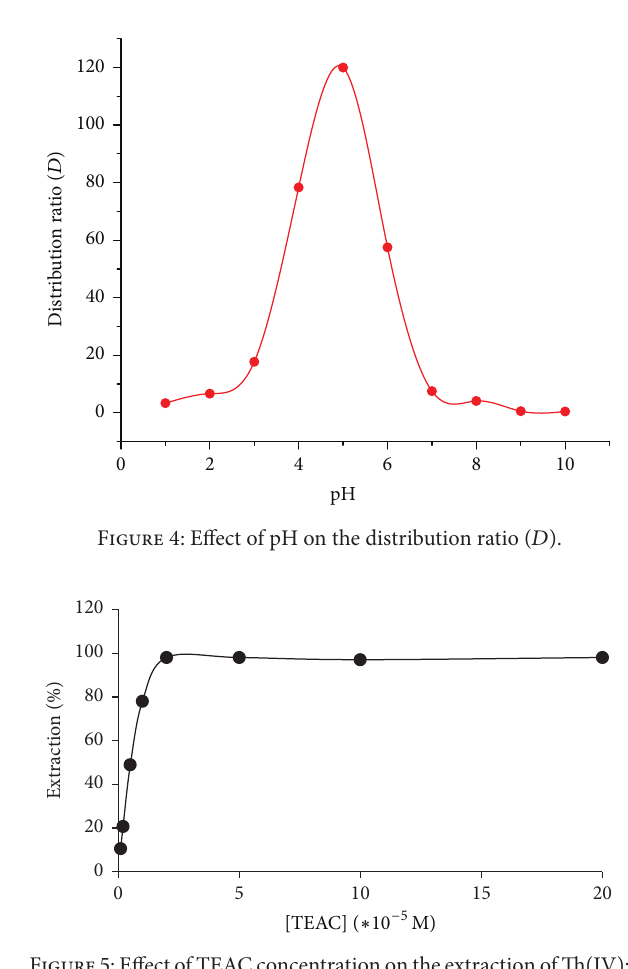
Figure 5: Effect of TEAC concentration on the extraction of Th(IV): chloroform as solvent, at 525 nm and Th(IV) 1 × 10 −4 M.